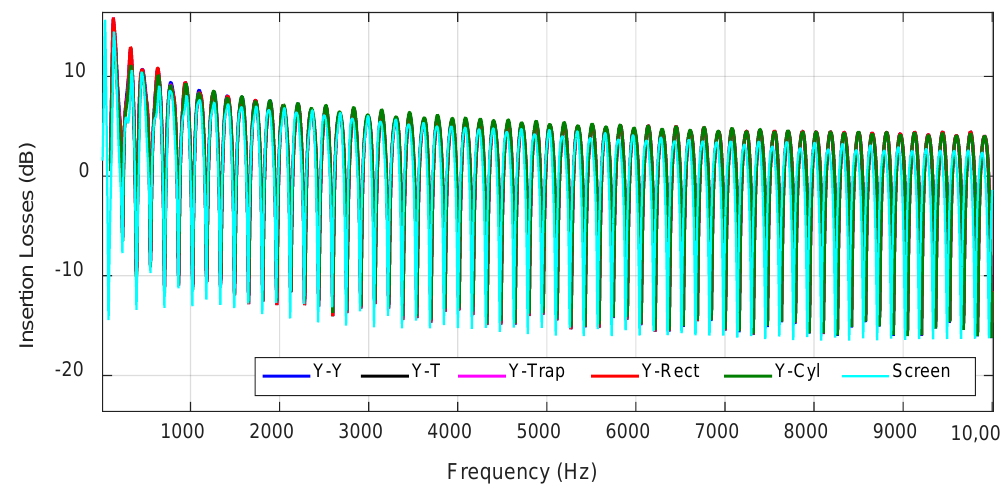
Figure 19. IL in Configuration 4 (‘Ambulance–Balcony’) using double caps formed with Y-shaped structures and a single screen barrier as a reference.